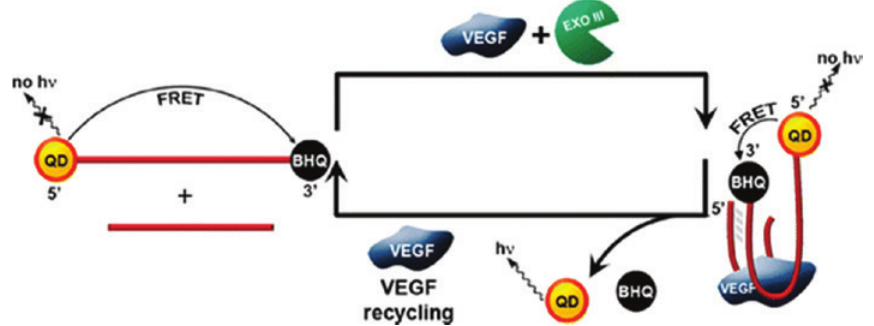
Figure 4: FRET analysis of VEGF165 by anti-VEGF aptamer-modified CdSe/ZnS QDs. Reprinted with permission of Ref. [51]. © Copyright 2012 American Chemical